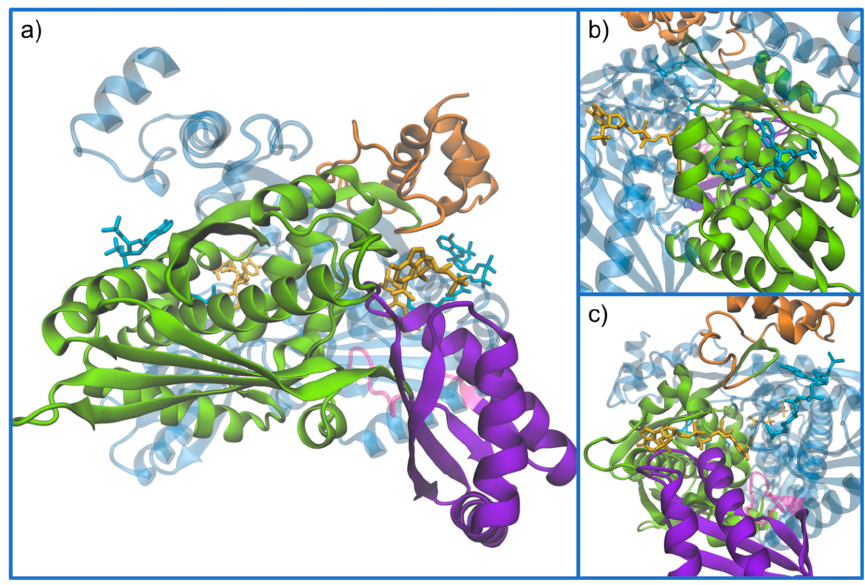
Figure 7. ( a ) Demonstration of the monomer subdomains. The structures follow the representation and color code of the dimer in Figure 6, as chain A and B are colored in magenta and blue (transparent to better see details), respectively. The chain A monomer is subdivided into its subdomains, highlighted in orange is the N-domain; in green the L-domain; in violet the S-domain; and the molecules represented are CoA (in light blue) and NADPH (in yellow). ( b , c ) Close-up representations of the CoA and NADPH-binding regions, respectively (PDB entry 1DQA). Molecules 2020 , 25 , x